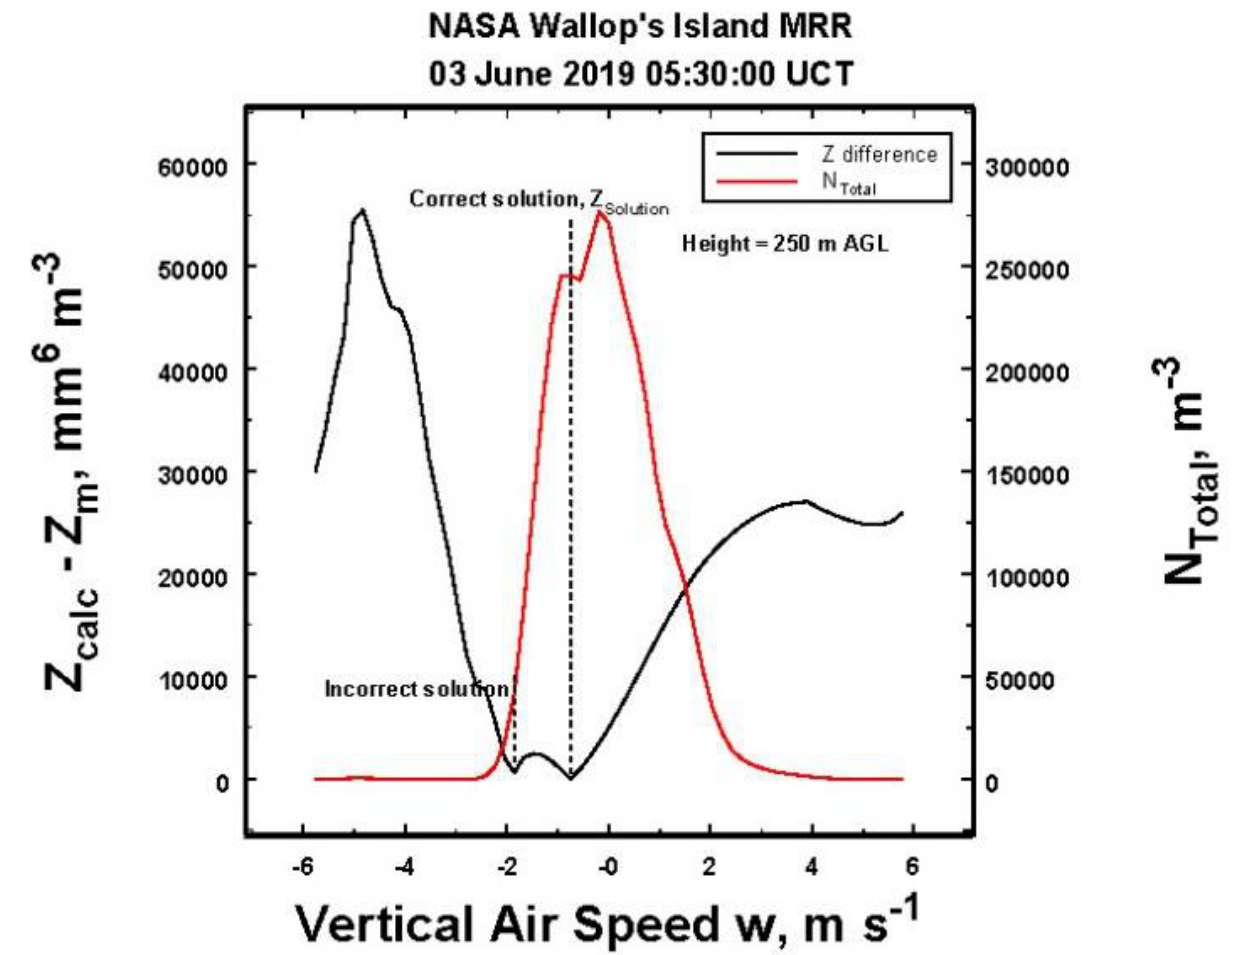
Figure 5. A plot of the difference between the measured ( Z m ) and the calculated Z ( Z calc ), illustrating that the likely correct solution ( Z Solution ) is associated with large values of the total number of drops as appears to always be the case in this study.